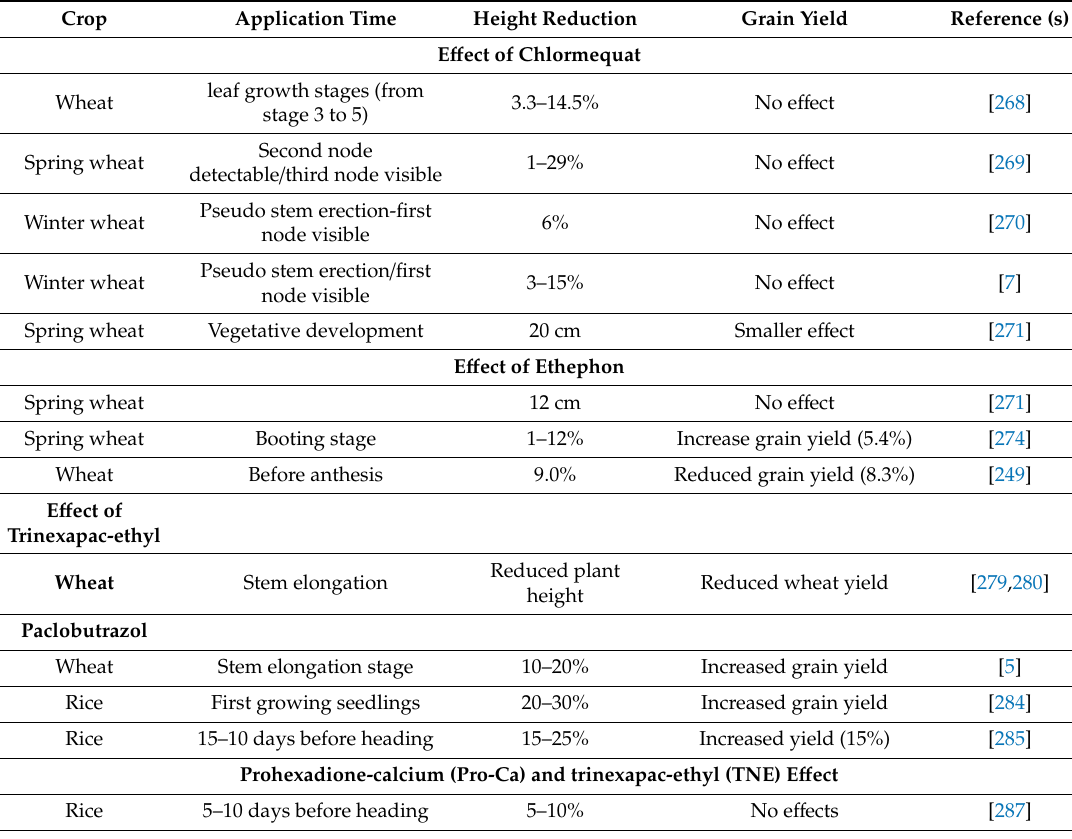
Table 5. Role of plant growth regulators for reducing lodging stress in wheat and